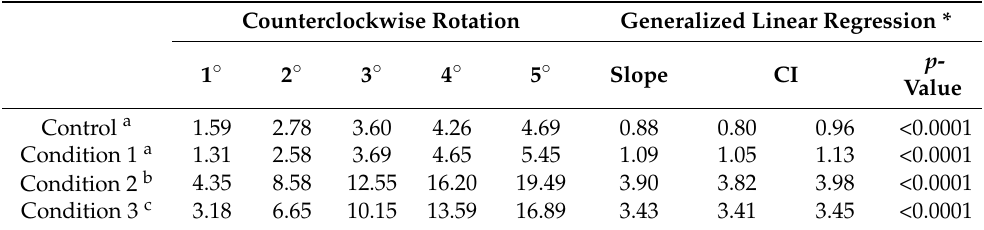
Table 5. Moment (Nmm) required to unwind the orthodontic miniscrew at the middle of the trabecular bone in each degree of counterclockwise